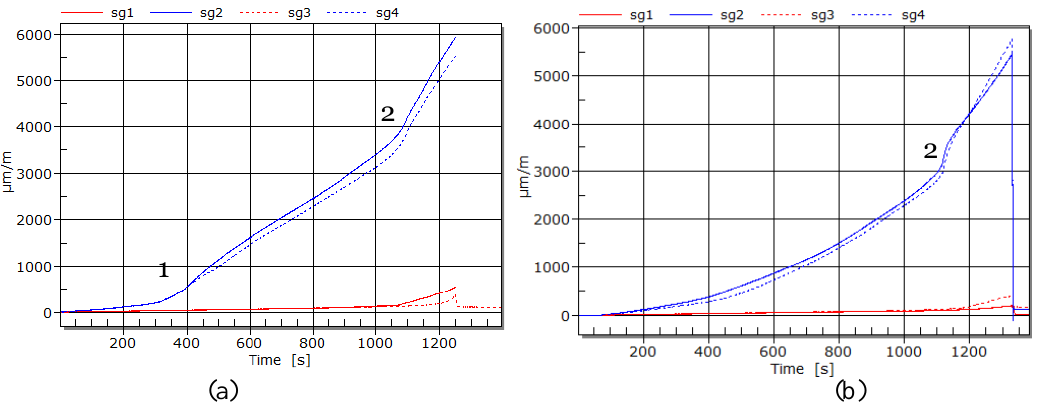
Figure 12. Strain development in CFRP at mid span in ( a ) A.0 ( b ) A.70.